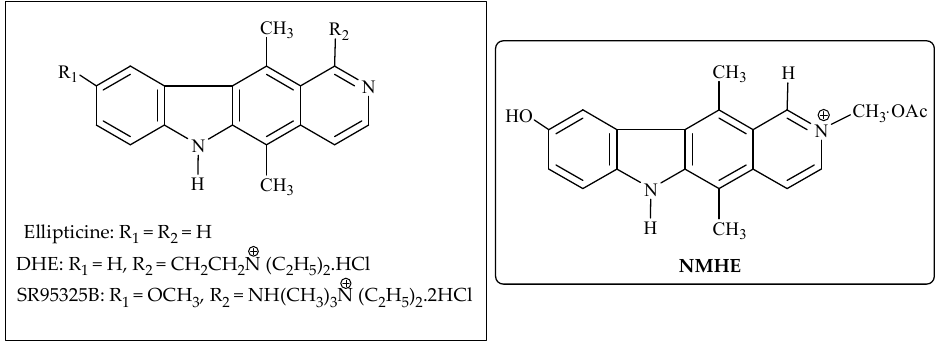
Figure 12. Ellipticine and its analogs.